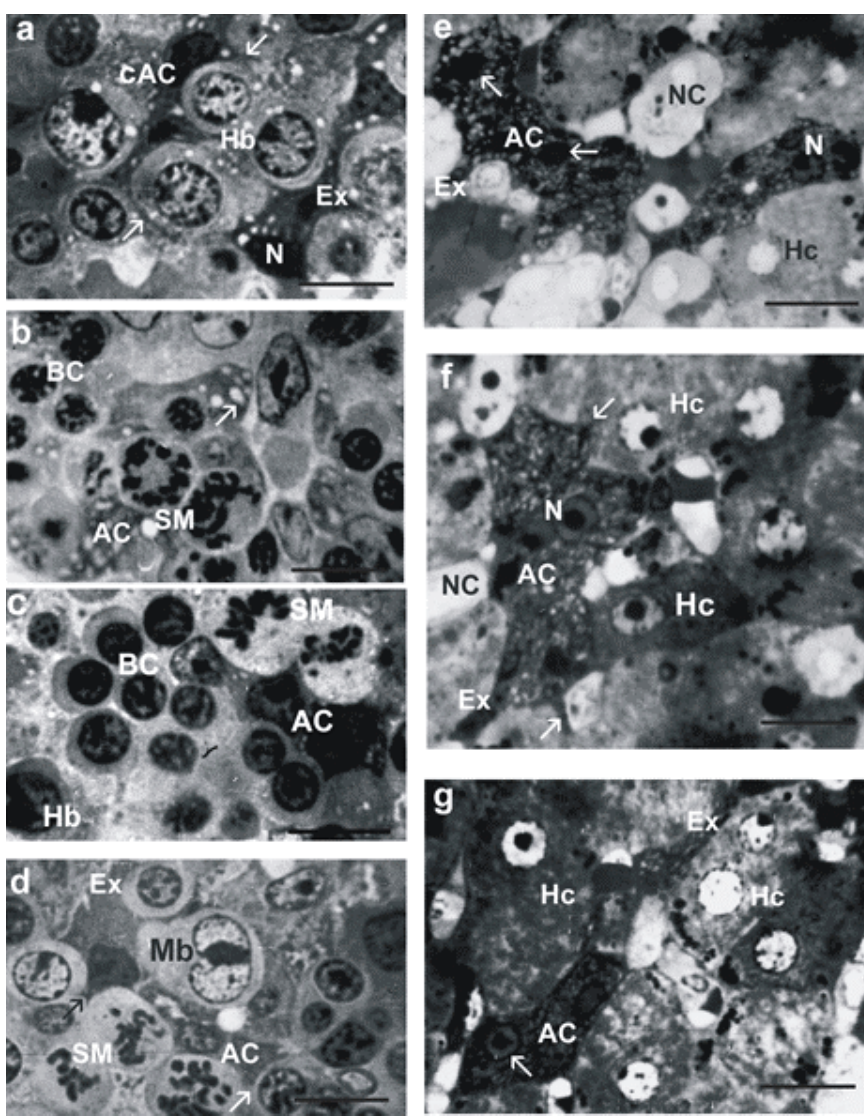
FIGURE 1. Apoptotic cells in liver tissue of intact embryos and young rats after cycloheximide administration. (a) Clusters of two to three apoptotic cells (cAC) adjoining hepatoblasts (Hb); condensed nuclei (N) and polymorphic excrescences (Ex, arrows). ED15. (b) Apoptotic cells contain large vacuoles (arrow) adjoining synchronous mitosis (SM). ED19. (c) Group of irregular cells at different levels of contact stage of apoptosis adjoining synchronic mitosis; blood cells (BC). ED17. (d) Soma and excrescences of apoptotic cells surrounding megakaryoblast (Mb) and synchronous mitosis. ED19. (e) Irregular apoptotic cells with dark and condensed nuclei (arrows) adjoining hepatocytes (Hc) and necrotic cells (NC). Two hours after injection of cycloheximide. (f) Binuclear apoptotic hepatocyte with polymorphic excrescences (arrows) adjoining intact hepatocytes; apoptotic hepatocyte with elongated excrescences (Ex). Three hours after injection of cycloheximide. (g) Irregular apoptotic cell adjoining large intact hepatocytes. In nucleus of apoptotic hepatocyte (arrow) possibly new formed nucleolus. Excrescences of apoptotic cells are seen between the hepatocytes. Four hours after injection of cycloheximide. Scale bars 50 μ